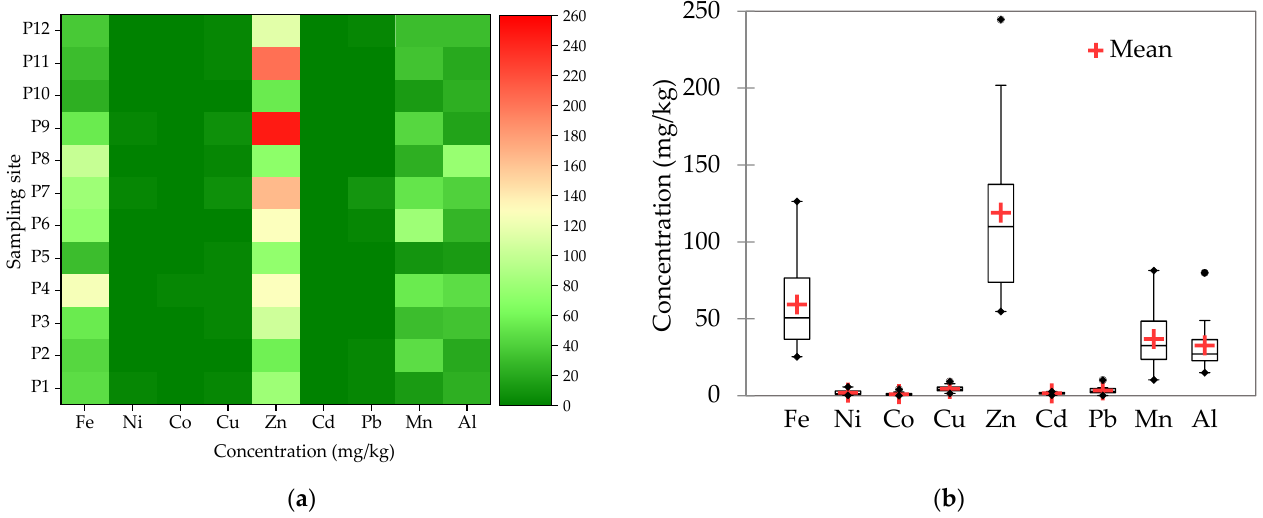
Figure 4. Concentration of metals in poplar leaves: ( a ) Concentration; ( b ) Minimum, average, and maximum.